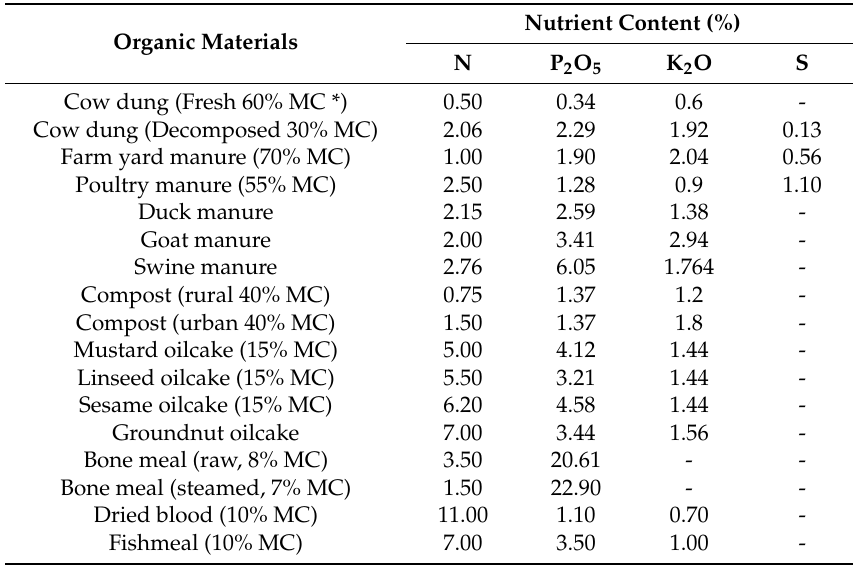
Nutrient contents (%) of some commonly used organic materials in South and SE Asia (adapted from BARC, 2012 and Timsina, 2018, with permission from BARC, Bangladesh, 2012 and Agriculture & Forestry University, Nepal,